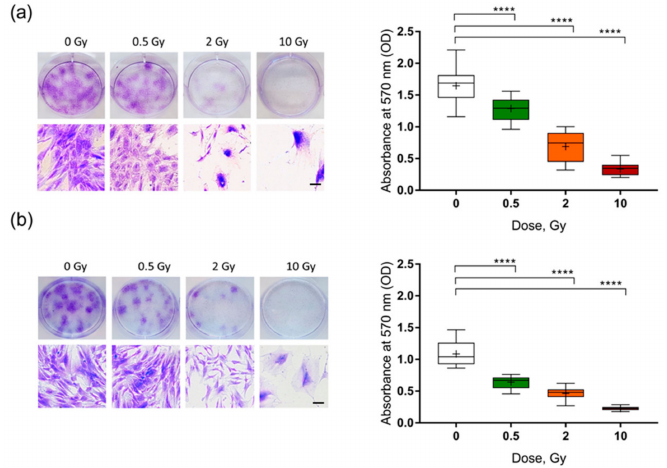
Figure 2. Clonogenic capacity of human pre-adipocytes after X-ray irradiation. ( a ) Human primary pre-adipocytes and ( b ) SGBS pre-adipocytes were exposed to 0.5, 2 and 10 Gy X-rays. Staining with crystal violet and quantitative analysis was performed on day 14. Boxplots show the median, Tukey whiskers (median ± 1.5 times interquartile range), and mean (+). N = 6, **** p ≤ 0.0001, using a two-tailed t -test. Scale bar represents 100 µ